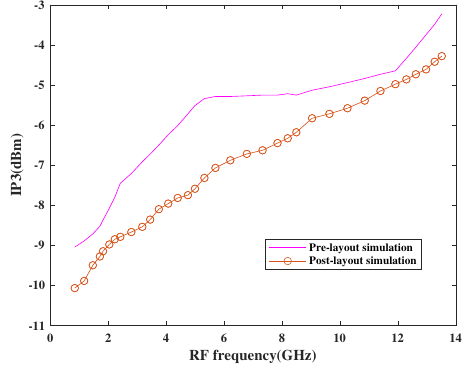
Figure 15. Variation of IP3 with RF